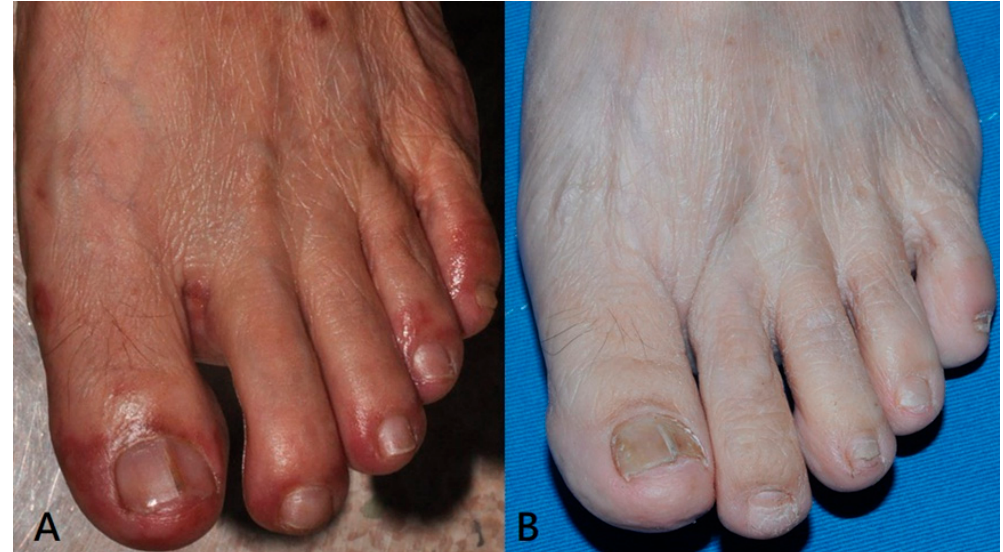
Figure 1. ( A ) In the acute stage, the cutaneous lesions, such as erythematous papules and pustules, around the nail matrix of the first, fourth and fifth toenails of left foot are relatively prominent than on the second and third toe; ( B ) about two months later, onychomadesis on the second and third toe of left foot.